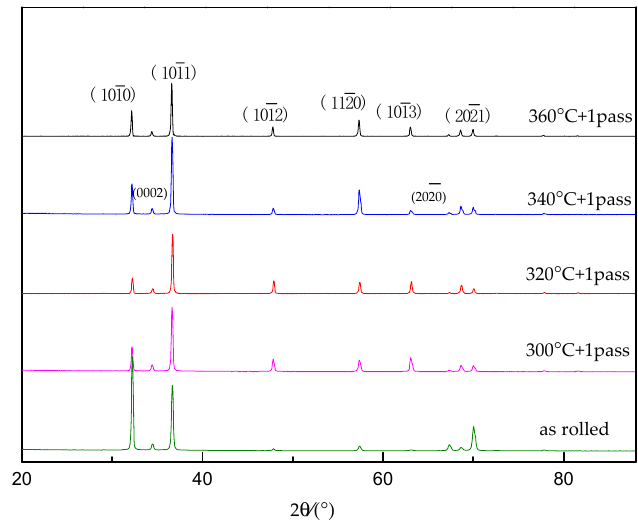
Figure 7. XRD spectra of Mg-2Y-0.6Nd-0.6Zr alloy during ECAP deformation at different temperatures.